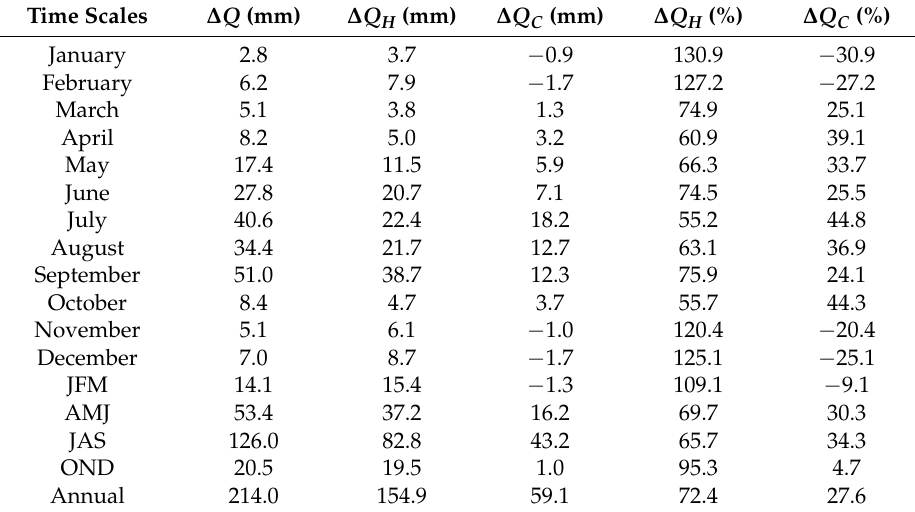
Table 10. Quantitative impacts due to two factors (Seom River